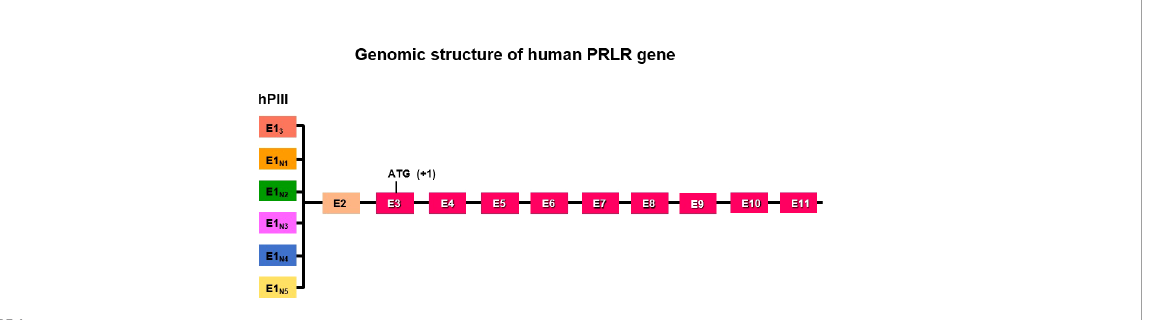
FIGURE 1 Schematic representation of multiple exons 1 (hE1 3, hE1 N1-5 ) driven by individual promoters and alternative splicing to common exon 2 of human PRLR. Exon 3 has initiation codon. PIII/hEI3 is the predominantly utilized generic promoter in addition to fi ve speci fi c exon 1/promoters (hE1N1 to hE1N5).